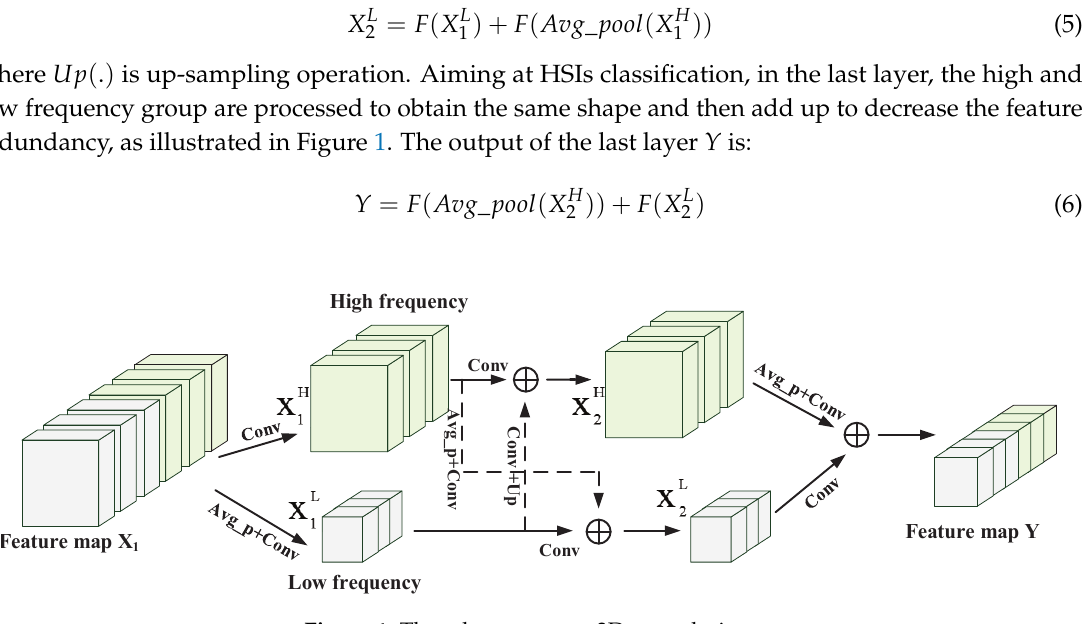
Figure 1. Three layers octave 3D